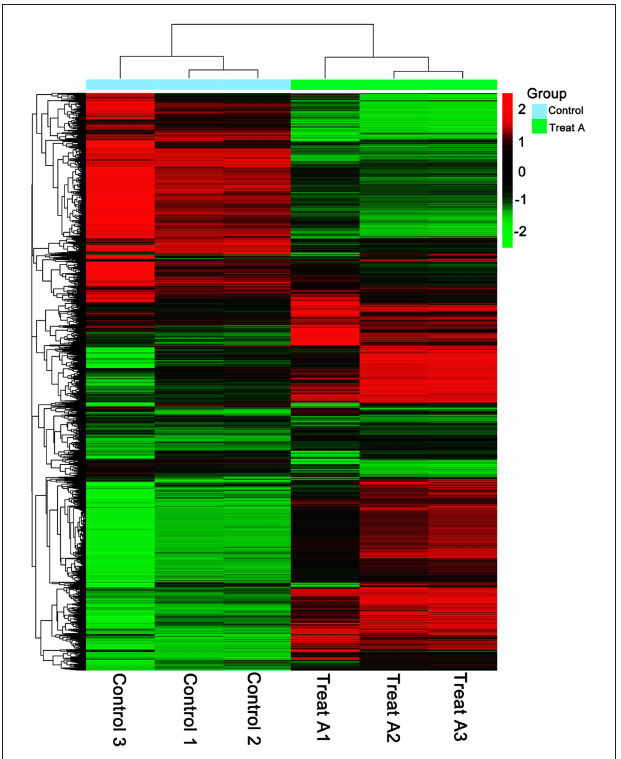
FIGURE 2 | Heat map of lower (green) and higher (red) DEGs expression levels.